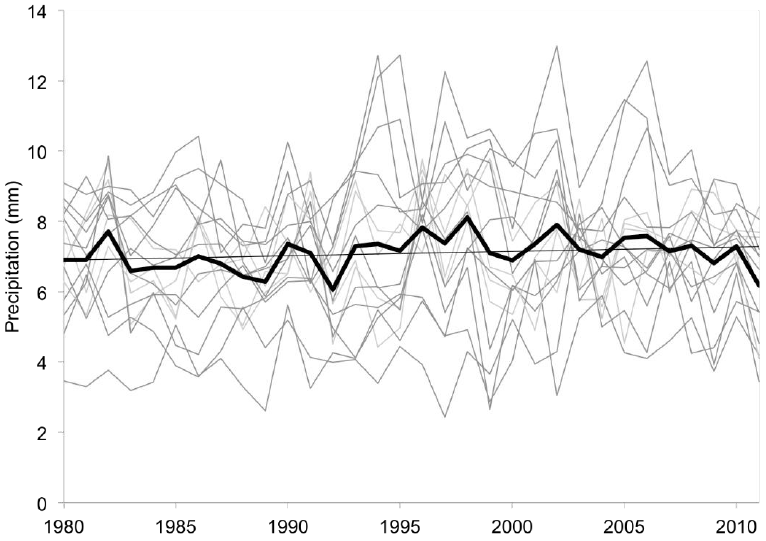
Figure 5. This graph shows the monsoon average daily precipitation (mm). The black line indicates